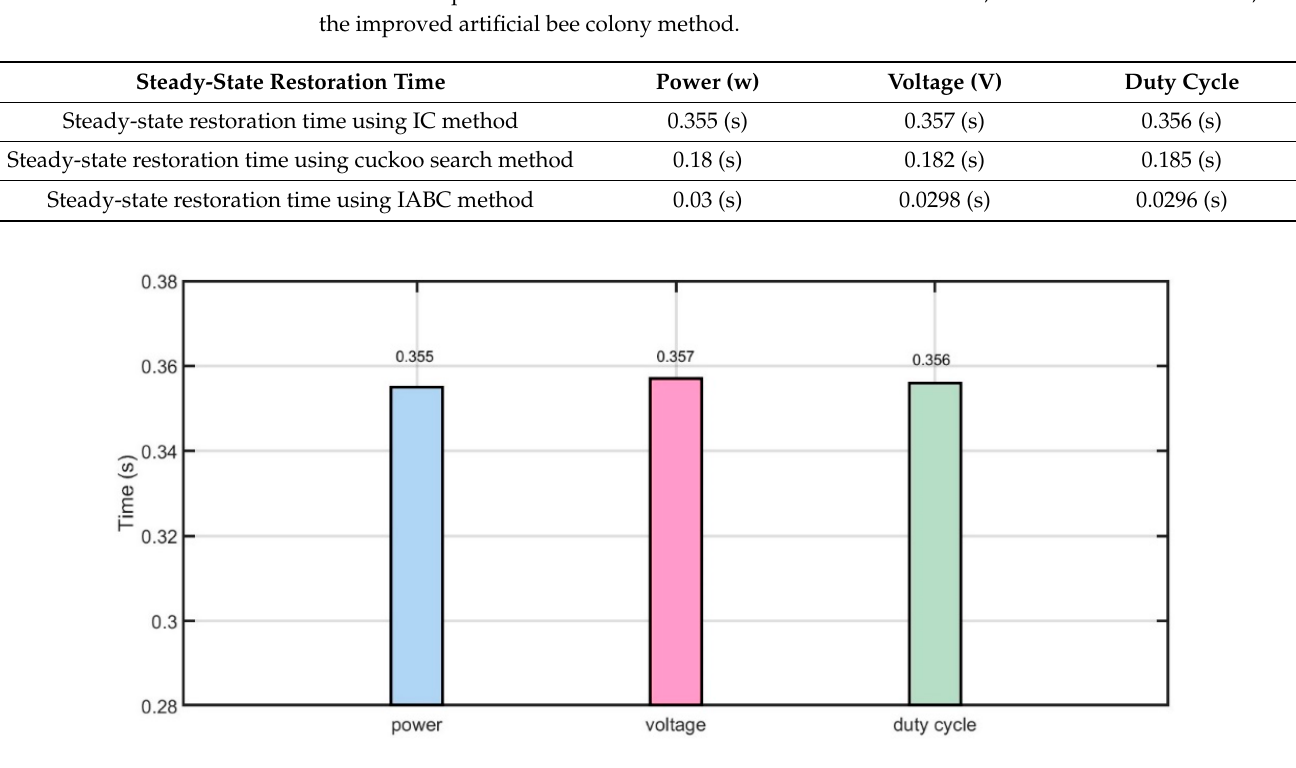
Figure 21. The steady-state restoration time using the IABC method. The average efficiency and tracking time for the IABC approach were both 88% on average, which resulted in a faster time to MPPT. In addition, the tracking time of IABC